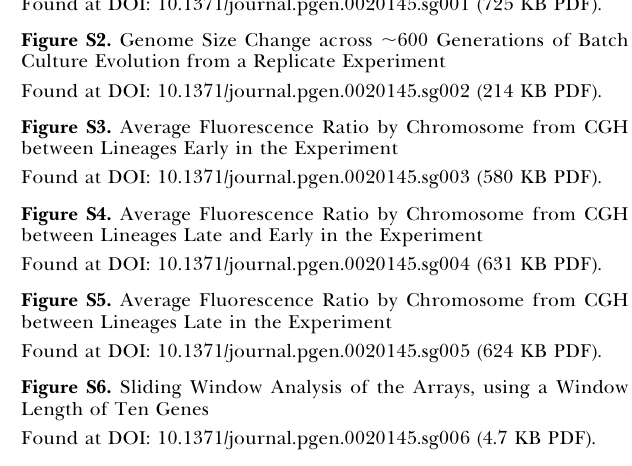
Figure S1. Temporal Polymorphism for Genome Size across 1,800 Generations of Batch Culture Found at DOI: 10.1371/journal.pgen.0020145.sg001 (725 KB PDF). Figure S2. Genome Size Change across ; 600 Generations of Batch Culture Evolution from a Replicate Experiment Found at DOI: 10.1371/journal.pgen.0020145.sg002 (214 KB PDF). Figure S3. Average Fluorescence Ratio by Chromosome from CGH between Lineages Early in the Experiment Found at DOI: 10.1371/journal.pgen.0020145.sg003 (580 KB PDF). Figure S4. Average Fluorescence Ratio by Chromosome from CGH between Lineages Late and Early in the Experiment Found at DOI: 10.1371/journal.pgen.0020145.sg004 (631 KB PDF). Figure S5. Average Fluorescence Ratio by Chromosome from CGH between Lineages Late in the Experiment Found at DOI: 10.1371/journal.pgen.0020145.sg005 (624 KB PDF). Figure S6. Sliding Window Analysis of the Arrays, using a Window Length of Ten Genes Found at DOI: 10.1371/journal.pgen.0020145.sg006 (4.7 KB PDF). Figure S7. Genome Size Measured from Ten Populations (B1–B10) Evolved by Repeated Bottlenecking for 566 Generations and Five Populations (S1–S5) Evolved through Batch Culture Transfers for 558